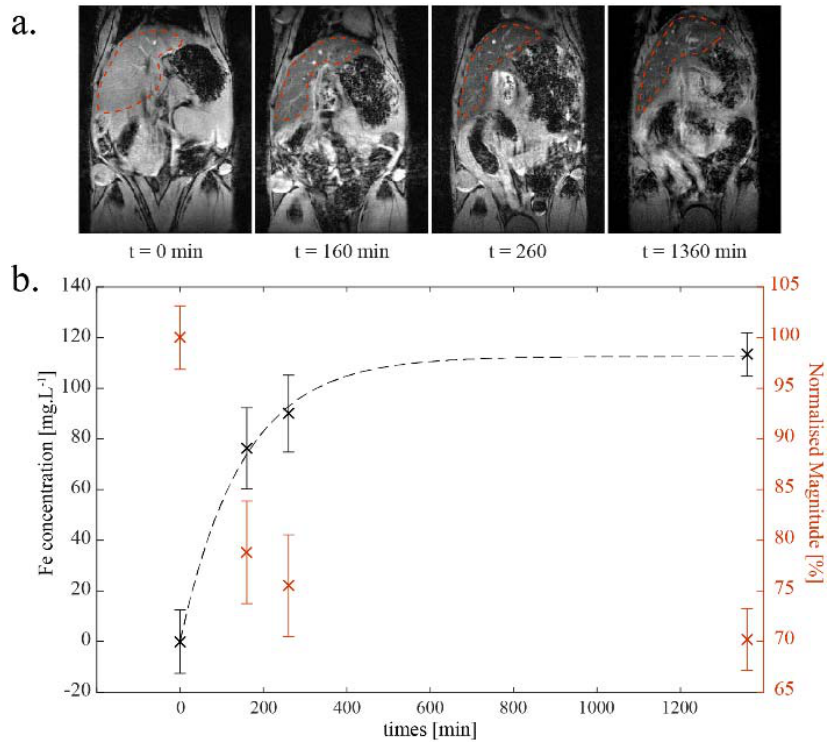
Figure 2. NE-P3 (#5) half-life in the bloodstream was determined by dynamic MRI. ( a ): MR images at different time points showing the regions of interest (ROI, inside the red dashed lines) that encompass the liver and were used to measure the mean magnitude of the signal. ( b ): Mean normalized magnitude of the signal (red) and the corresponding iron concentration (black) estimated from the transverse relaxivity r (cid:2870)∗ of NE- P3 (#5). Error bars come from the normalized magnitude’s standard deviation of the voxels included in each ROI. The conjugation of biological moieties (scFv-Fc-2Cys P3 HuAb) to the PEGylated NE surface decreased the NE’s half-life in the blood from 139 min to 103 min (calculated from the graph of the iron concentration, dashed line). Table 2. Half-life of the tested NE formulations in the bloodstream.